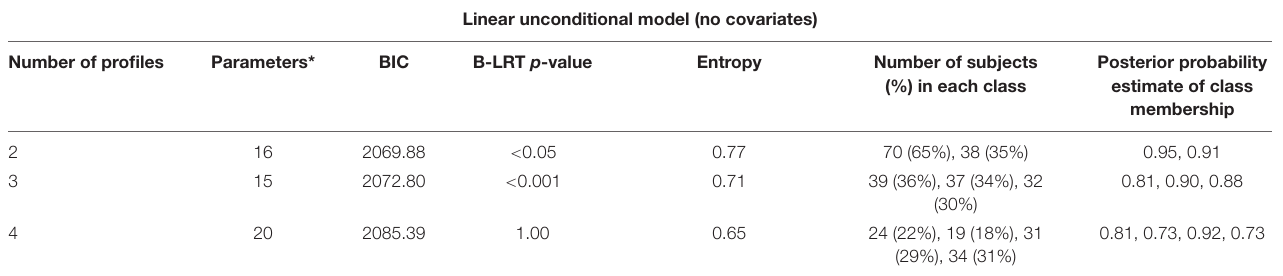
TABLE 2 | Information criteria and fit indexes for the unconditional GMM models.